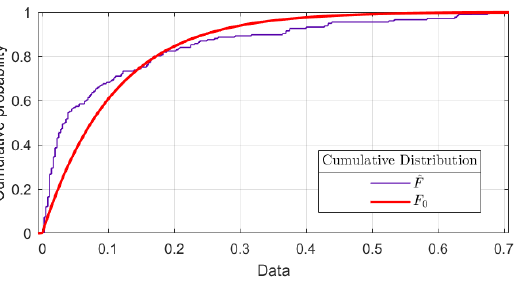
Figure 4. Superposition of reference theoretical F 0 and experimental ˆ F cumulative probability